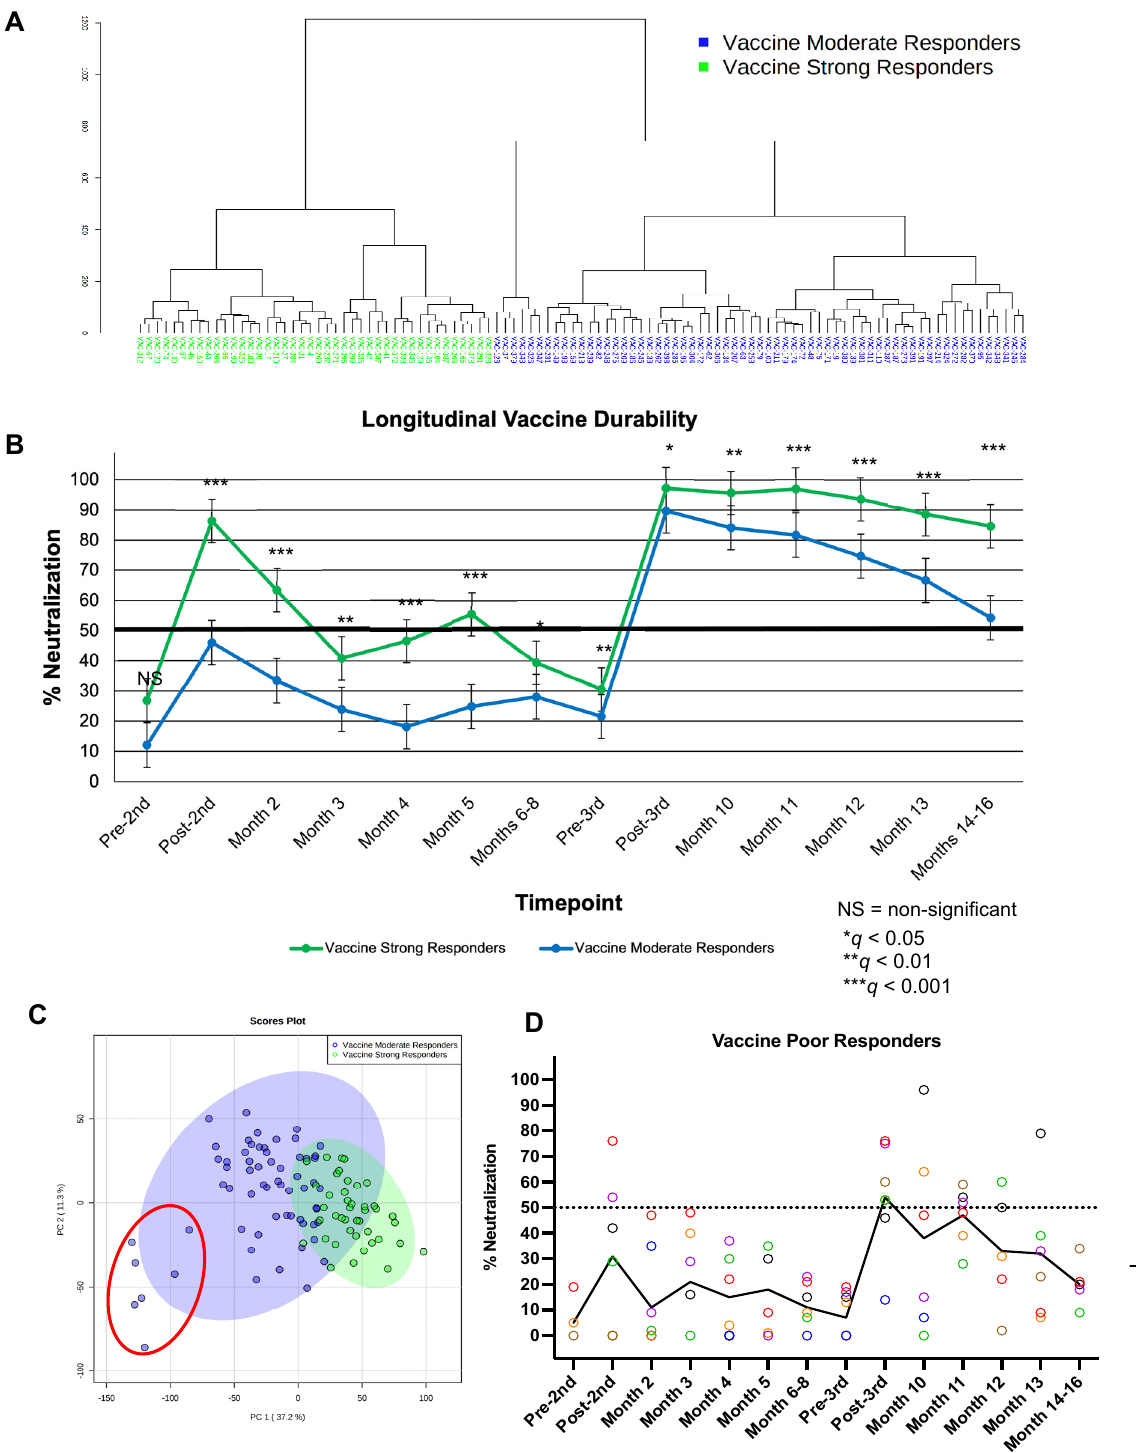
Figure 6. Grouping analyses of paired longitudinal NAb data. ( A ) Unsupervised hierarchical clustering analysis performed using 105 subjects with percent neutralization data collected at pre- and post-2nd dose, month 2, month 3, month 4, month 5, months 6–8, pre- and post-3rd dose, month 10, month 11, month 12, month 13, and months 14–16. Subjects were grouped as indicated by dendrogram and analysis of line graphs revealed the nature of two distinct groups (see ( B )): VSRs ( n = 42), VMRs ( n = 63). ( B ) Line graph showing longitudinal vaccine durability (i.e., percent neutralization by time in response to 2nd and 3rd doses) between VSRs ( n = 42) and VMRs ( n = 63). Data were